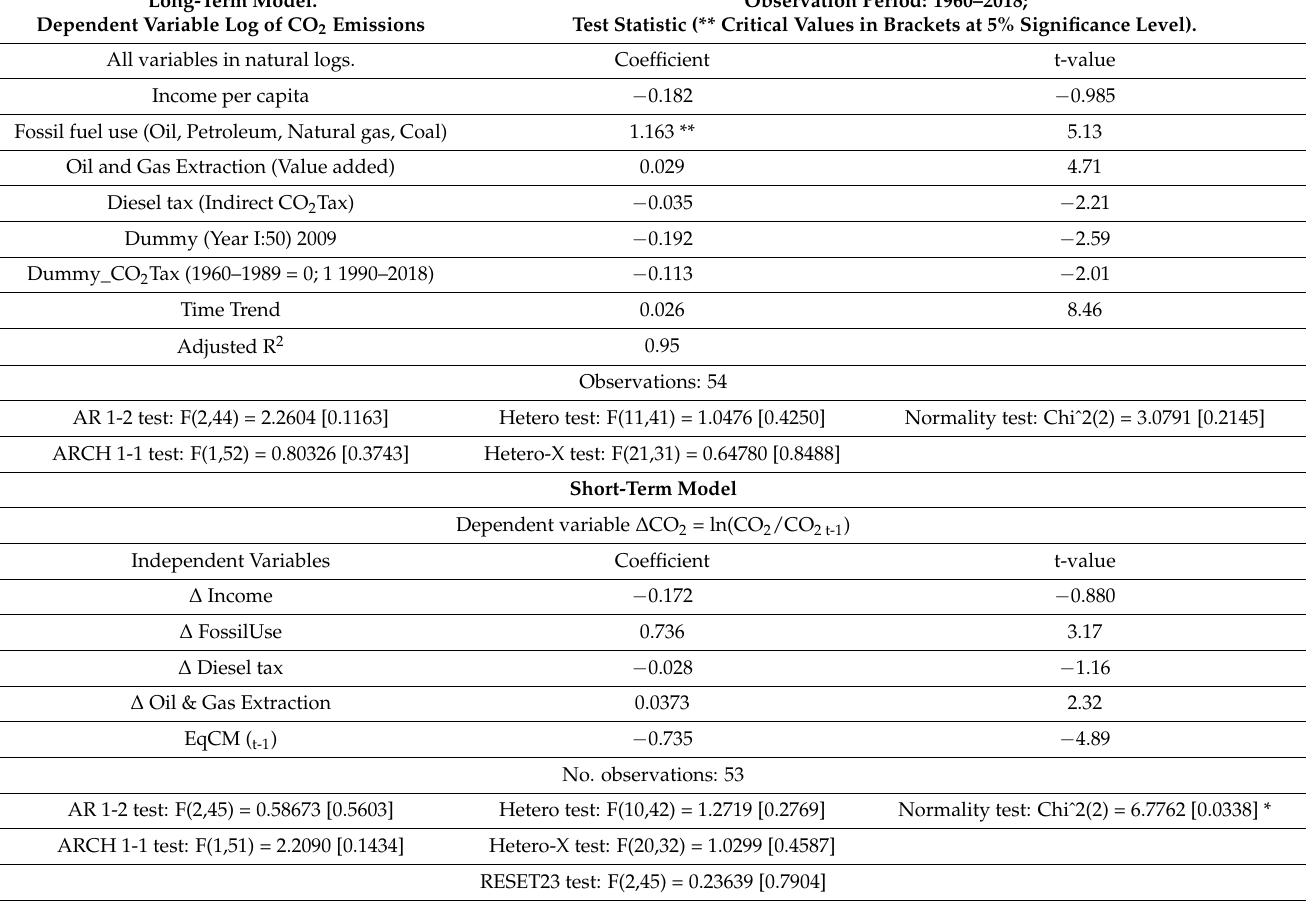
Table 6. Error correction model: